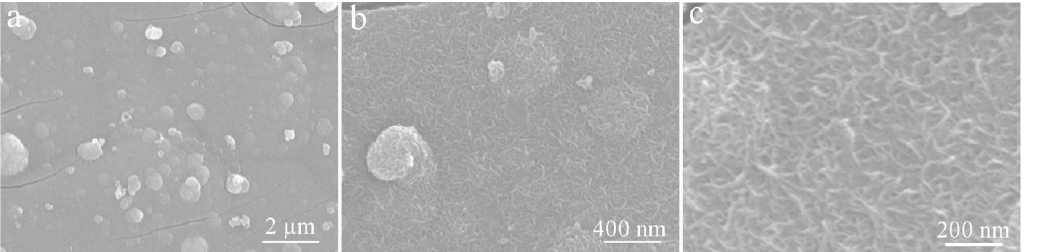
Figure 5. ( a ) CV curves at 10 mV s − 1 ; ( b ) GCD curves and ( c ) specific capacitance at different current densities of the Cu(OH) 2 /Ni 3 S 2 , Ni 3 S 2 , and Cu(OH) 2 electrode.